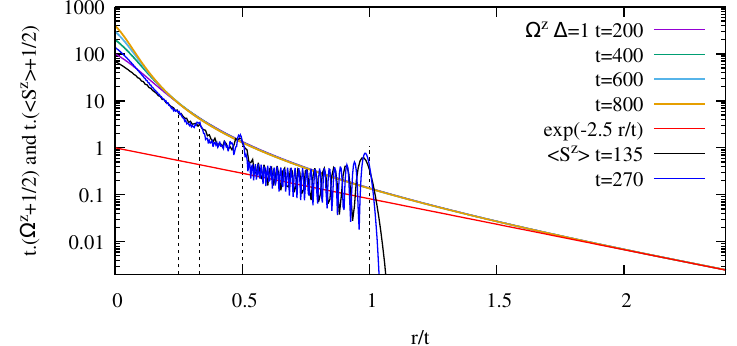
Figure 6: Zoom on the tail of the profile for ∆ = 1. For the LL model, we plot the quantity t · ( Ω z + 1 / 2 ) . The almost perfect collapse of the curves for different times shows that, at long times and large distances, we have Ω z + 1 / 2 (cid:39) 1 exp ( − cr / t ) . For t (cid:10) (cid:11) + 1 S z XXZ the black and blue lines correspond to the quantity in the Heisenberg 2 r chain (tDMRG) at t = 135 and t = 270 (the two curves are almost on top for of each other). The data are consistent with the scaling observed for LL. The vertical dotted lines are at r / t = 1 , 1 , 1 ,1, and correspond to the maximum group velocities 4 3 2 of bound-states of 4, 3, 2 and 1